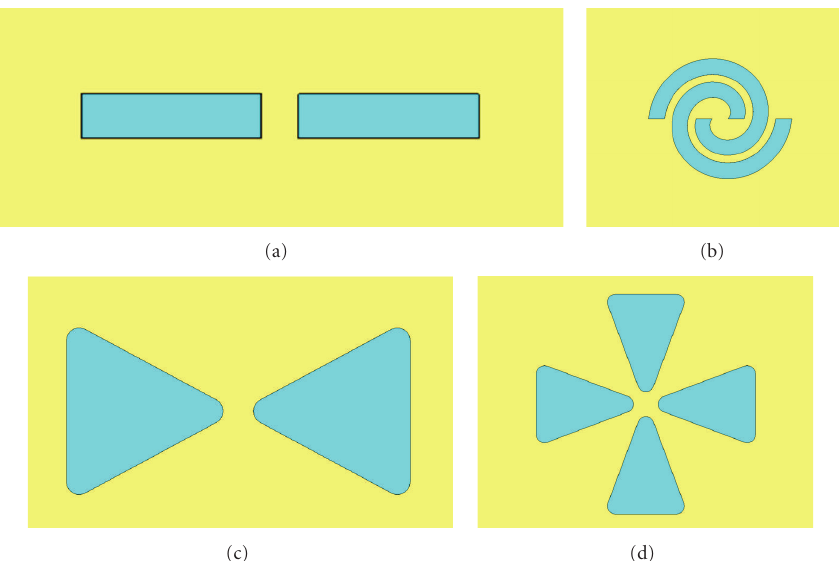
Figure 1: Nanoantenna structures considered for surface plasmon enhancement: (a) dipole, (b) Archimedean spiral, (c) bowtie, and (d) double bowtie.